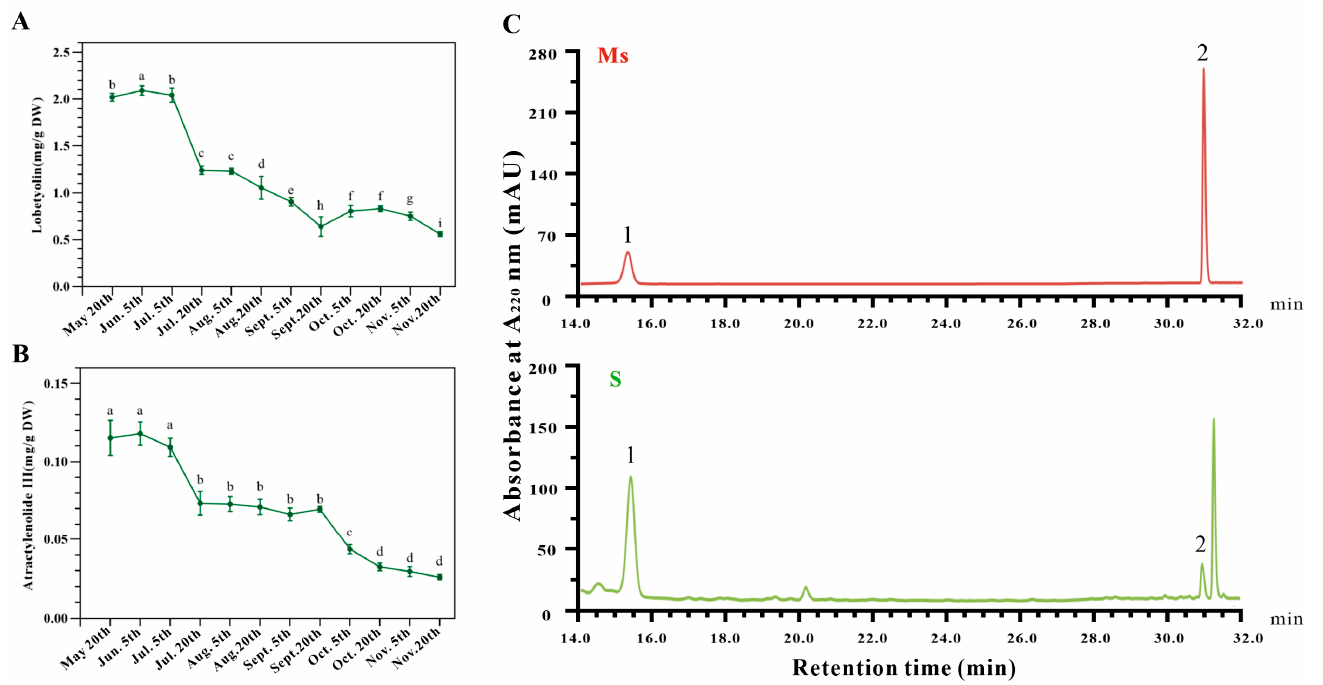
Figure 3. Dynamic changes in the lobetyolin ( A ) and atractylenolide III ( B ) contents of Codonopsis pilosula root at different growth stages. Values represent means ± SE ( n ≥ 3). DW: dry weight. Different letters above the bars indicate a significant difference ( p < 0.05) by one-way ANOVA with Tukey’s multiple comparison test. ( C ) HPLC profiles of lobetyolin and atractylenolide III. 1, lobetyolin; 2, atractylenolide III. Ms: mixed standards; S: Sample.